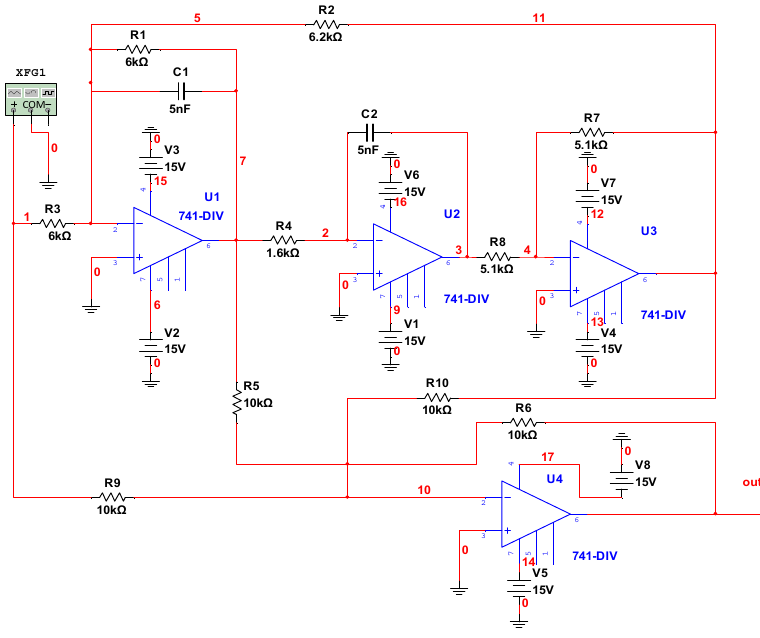
Figure 19. Four-op-amp biquad high-pass filter circuit.